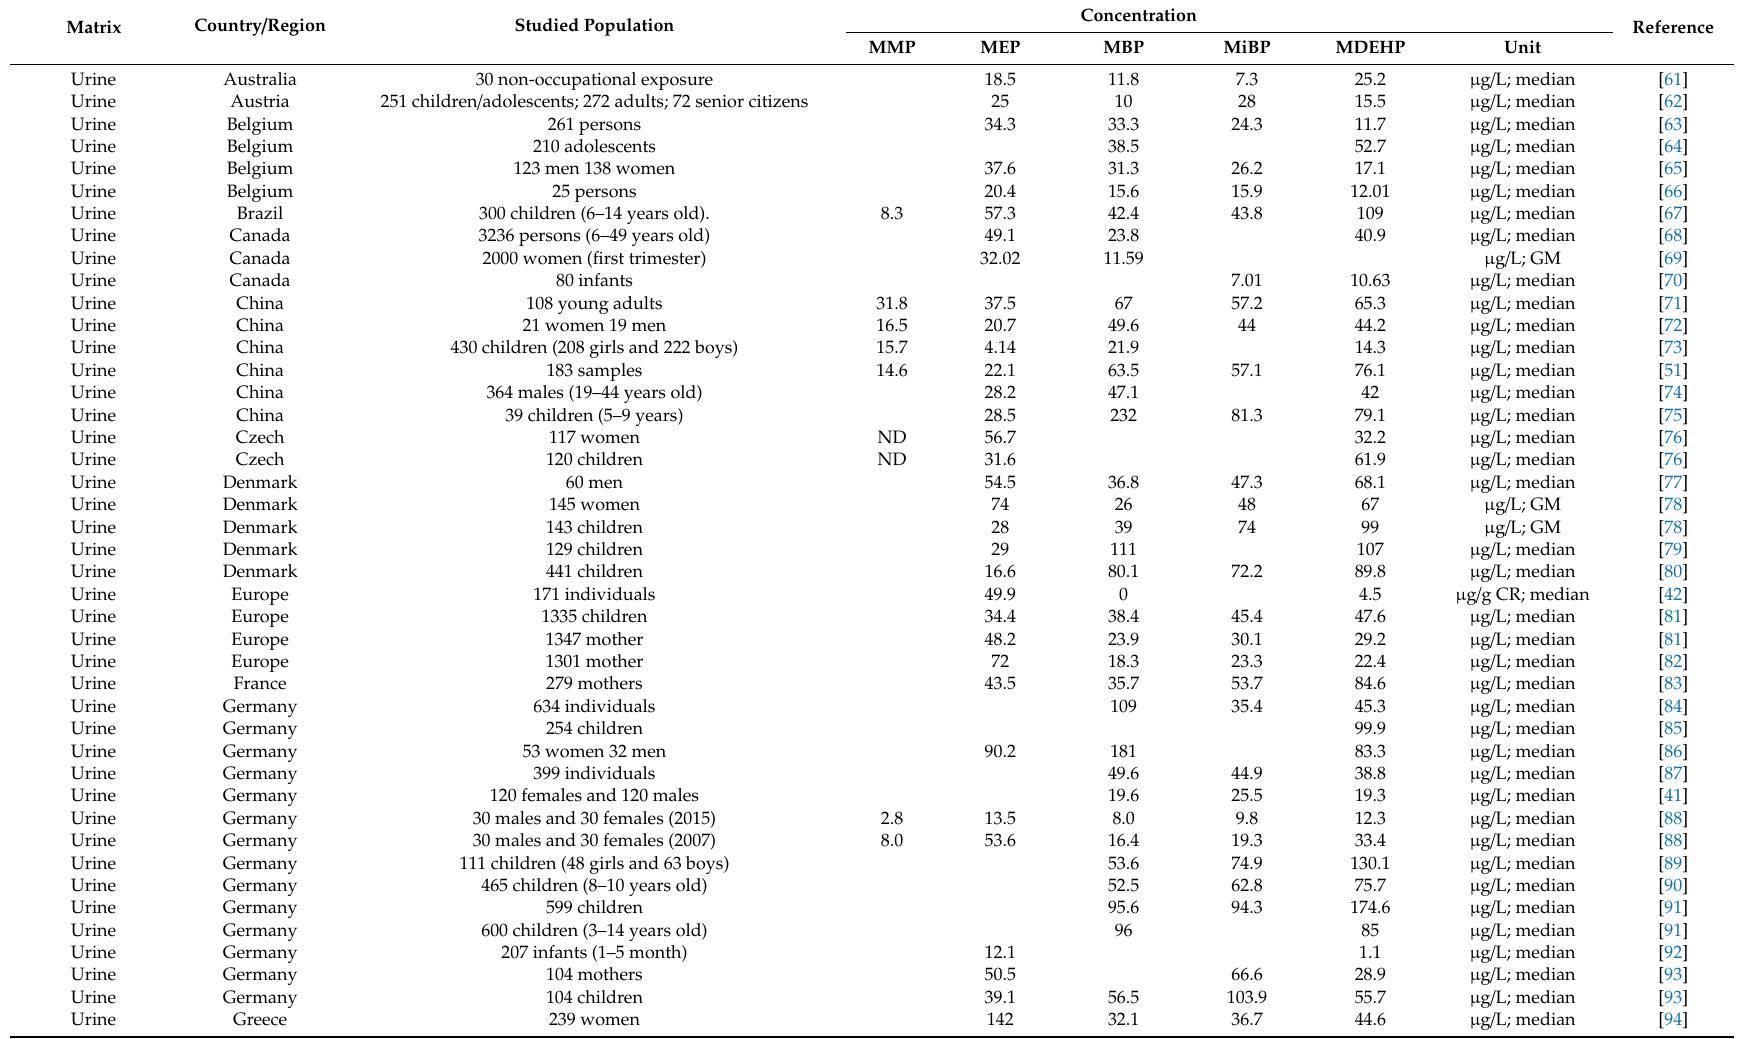
Table 3. Reported concentrations of major phthalate metabolites in human specimens collected from various